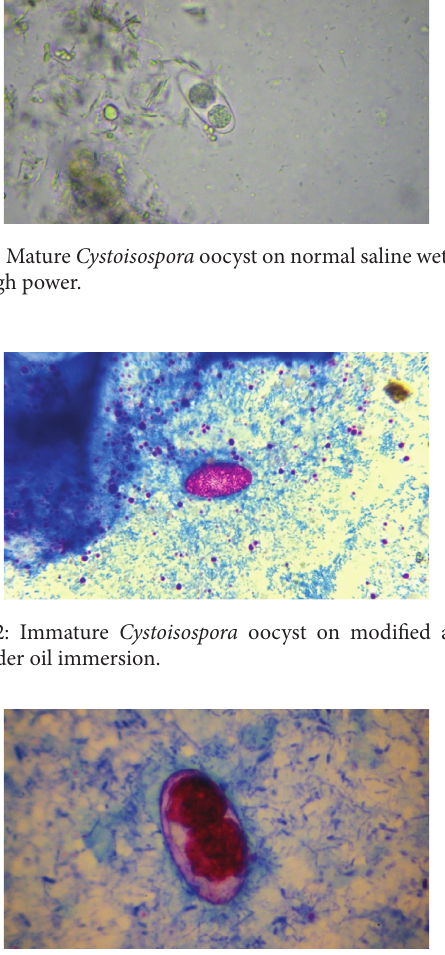
Figure 3: Mature Cystoisospora oocyst with two sporoblasts on modified acid-fast stain, under oil immersion.